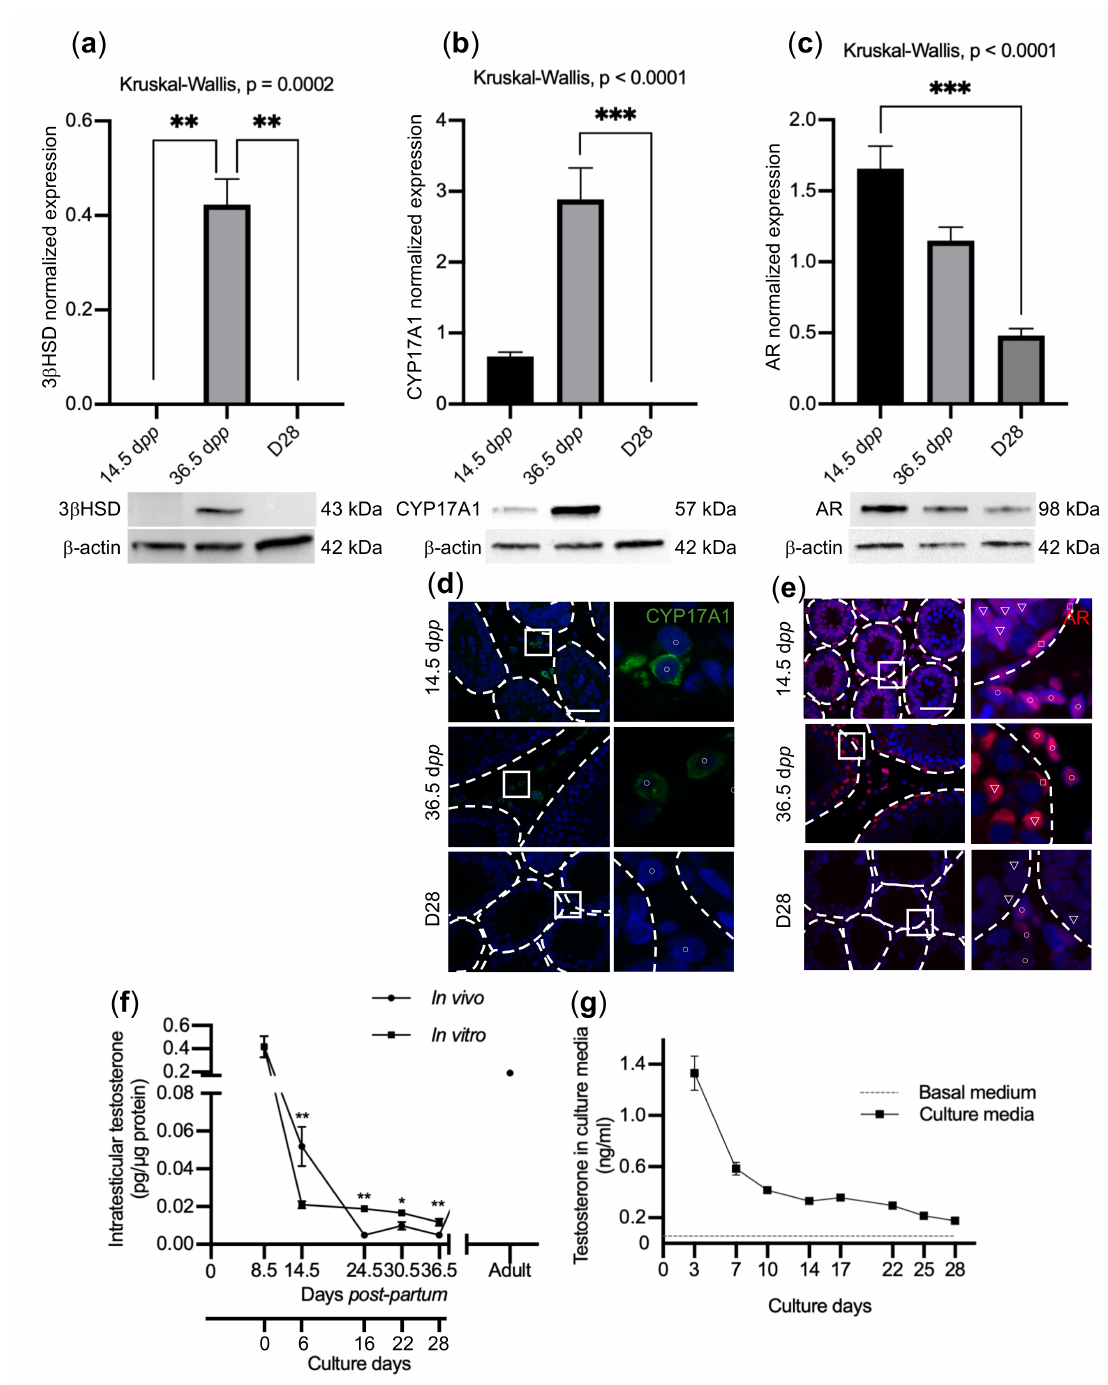
Figure 6. Analysis of steroidogenesis in in vitro culture. Expression of 3 β HSD ( a ), CYP17A1 ( b ), and AR ( c ) was quantified by western blot. Tissues cultured for 28 days (D28), and tissues recovered from age-matched in vivo controls (36.5 dpp) and from immature in vivo controls (14.5 dpp) were analysed. Representative data are presented. n = 6. ( d ) CYP17A1 immunostaining in Leydig cells (circle). ( e ) AR immunostaining in Sertoli cells (triangle), peritubular cells (square), and Leydig cells (circle). Seminiferous tubules are delimited by dotted lines, and the panels on the right represent enlarged views of the boxes. Scale bar: 50 µ m; Magnification: × 400. Intratesticular testosterone levels ( f ) and levels of testosterone in culture media ( g ). For statistical analyses, Kruskal–Wallis tests followed with Dunn’s post-test were applied for ( a – c ), and Mann–Whitney tests were applied for ( f , g ). Data are expressed as mean ± s.e.m. * p value < 0.05; ** p value < 0.01; *** p value <